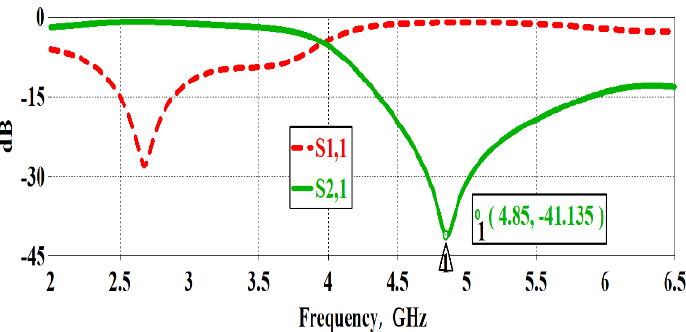
Figure 3. Simulated S-parameters of proposed DS-CSRR.